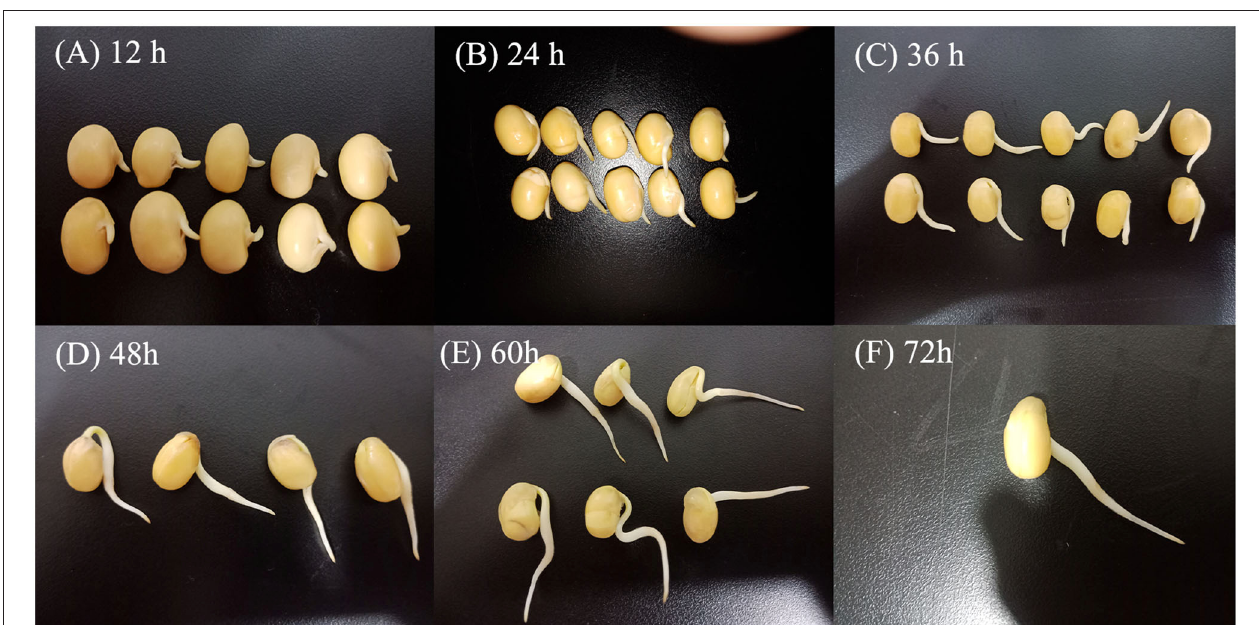
FIGURE 1 | Morphological changes of soybean in different germination stages. Germination for 12h (A) , germination for 24h (B) , germination for 36h (C) , germination for 48h (D) , germination for 60h (E) , and germination for 72h (F)